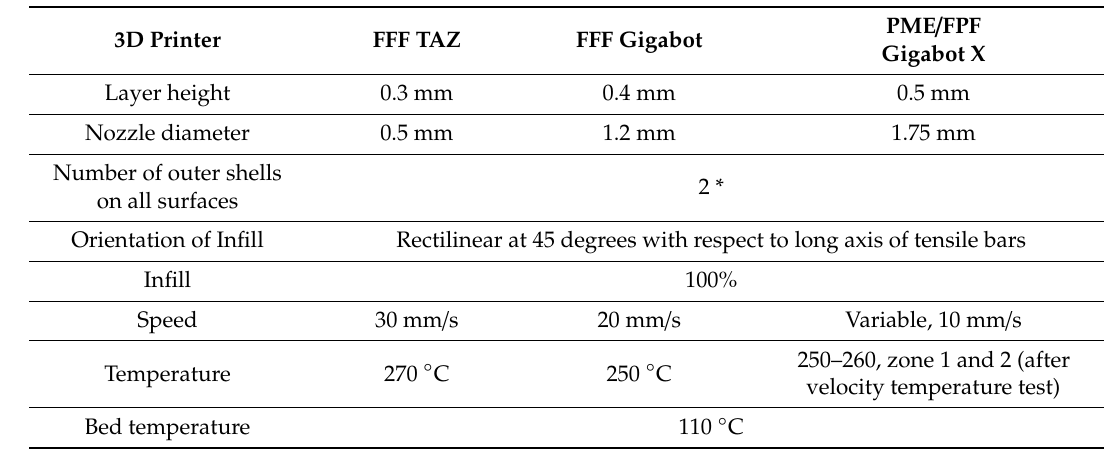
Table 1. 3D printer settings for all additive manufacturing (AM) systems